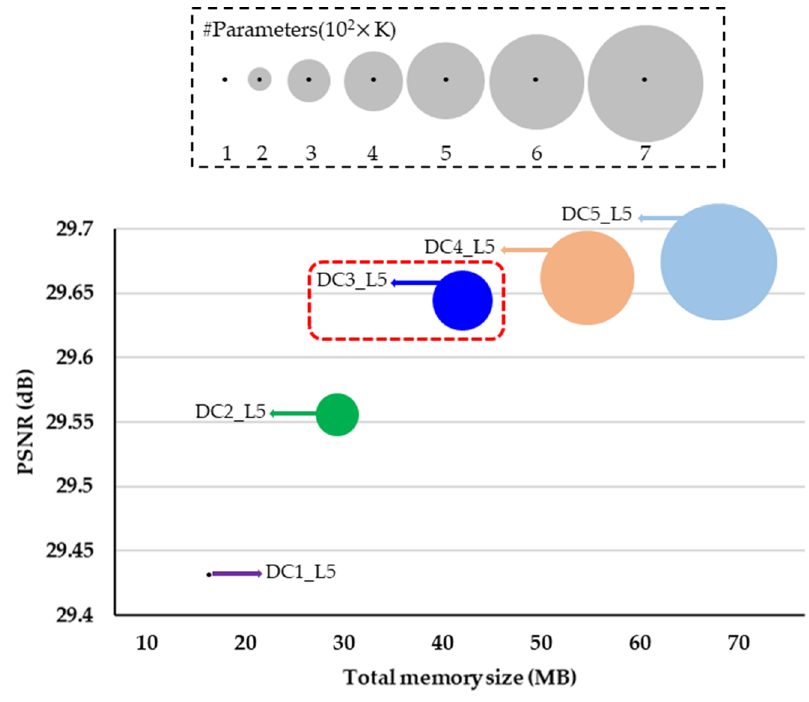
Figure 6. Verification of the number of DC blocks (DC) in terms of AR performance and complexity by using the Classic5 dataset. The circle size represents the number of parameters. The x and y-axis denote the total memory size and PSNR, respectively.